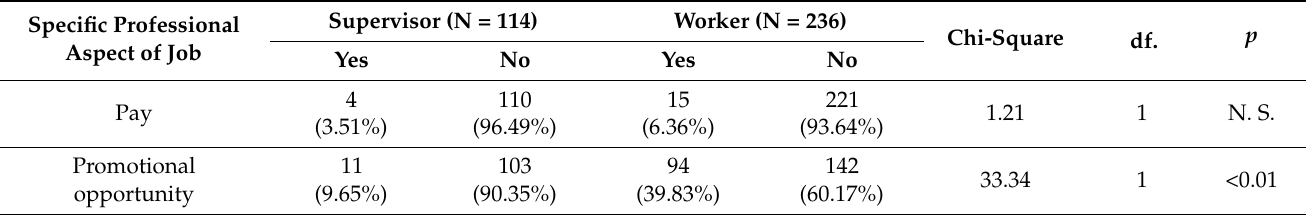
Table 7. Composite chi-square analysis of respondents’ satisfaction and dissatisfaction with specific professional criteria based on their level (N =